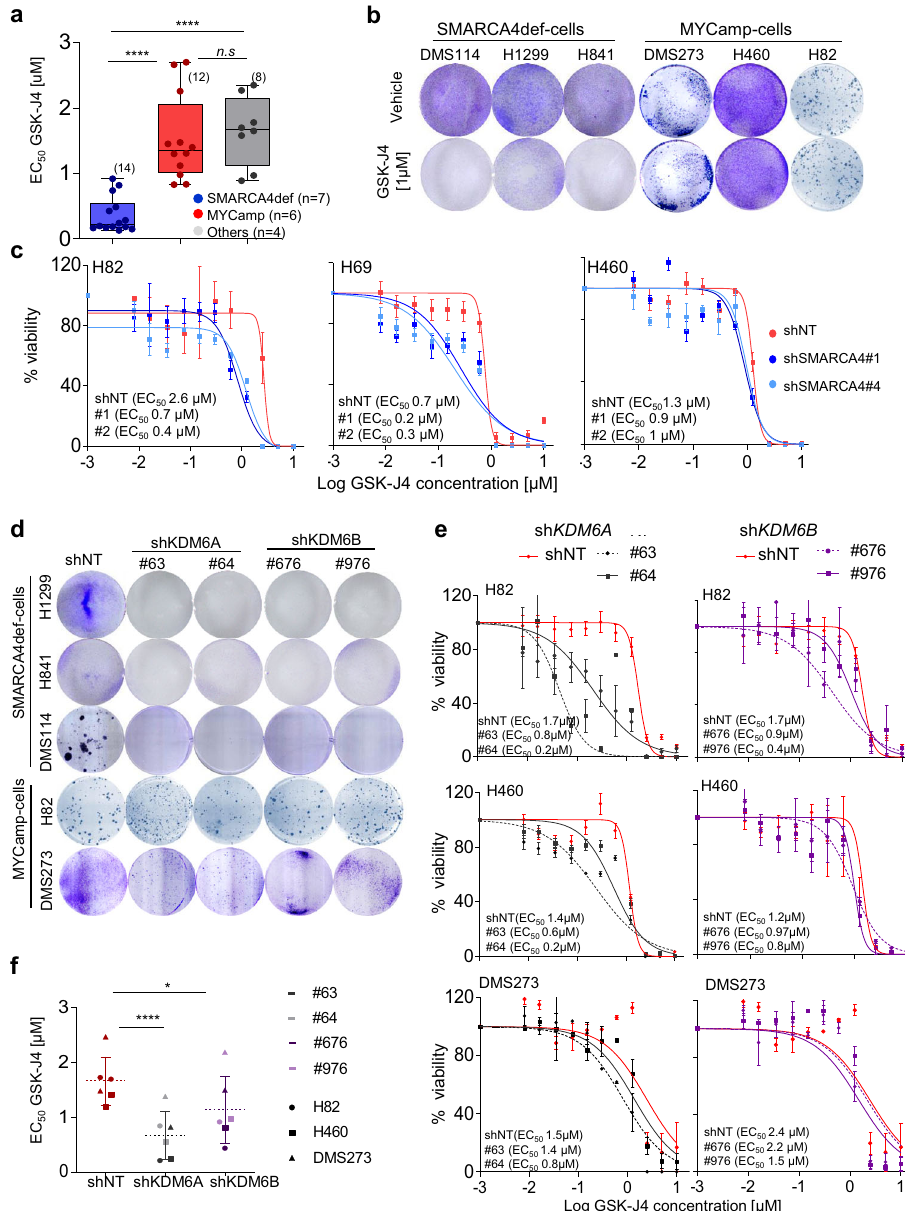
Fig. 4 SMARCA4def cells are vulnerable to KDM6s inhibition. a Distribution and mean of half-maximal effective concentration (EC 50 ) values for GSK-J4 (MTT assays. Supplementary Fig. 6a) in the indicated groups of cells. Values, from each cell line and from two independent experiments are represented. Two-sided unpaired Student ’ s t -test. **** P < 0.0001. In box-whisker plots, the horizontal band inside box indicates the median, the bottom and top edges of the box 25th – 75th percentiles and the whiskers indicate the min to max. b Representative clonogenic assays for the indicated cells and treatments. c Viability of the indicated cells infected with a short hairpin non-target (shNT) control or with two shRNAs targeting SMARCA4 (#1 and #4), measured using MTT assays, after treatment with increasing concentrations of GSK-J4 for 5 days. Lines, number of viable cells relative to untreated cells. Data are presented as mean and SD from three replicates and two experiments. d Representative clonogenic assays for the indicated cells infected with shNT, shKDM6A (#63, #64) or shKDM6B (#676, #976). e Viability of the indicated cell lines, measured using MTT assays, infected with a non-target (shNT) control or with two shRNAs targeting KDM6A or KDM6B after treatment with increasing concentrations of GSK-J4 for 5 days. Lines, number of viable cells relative to the untreated cells. Error bars, mean ± SD from triplicates. f Distribution and mean of the EC 50 from two independent experiments per each of the three LC cell lines. Lines show mean ± SD. P -values were calculated using paired two-tailed Student ’ s t test. * P = 0.015; **** P < 0.0001; ns, not signi fi cant. A Source Data fi le is available for this fi